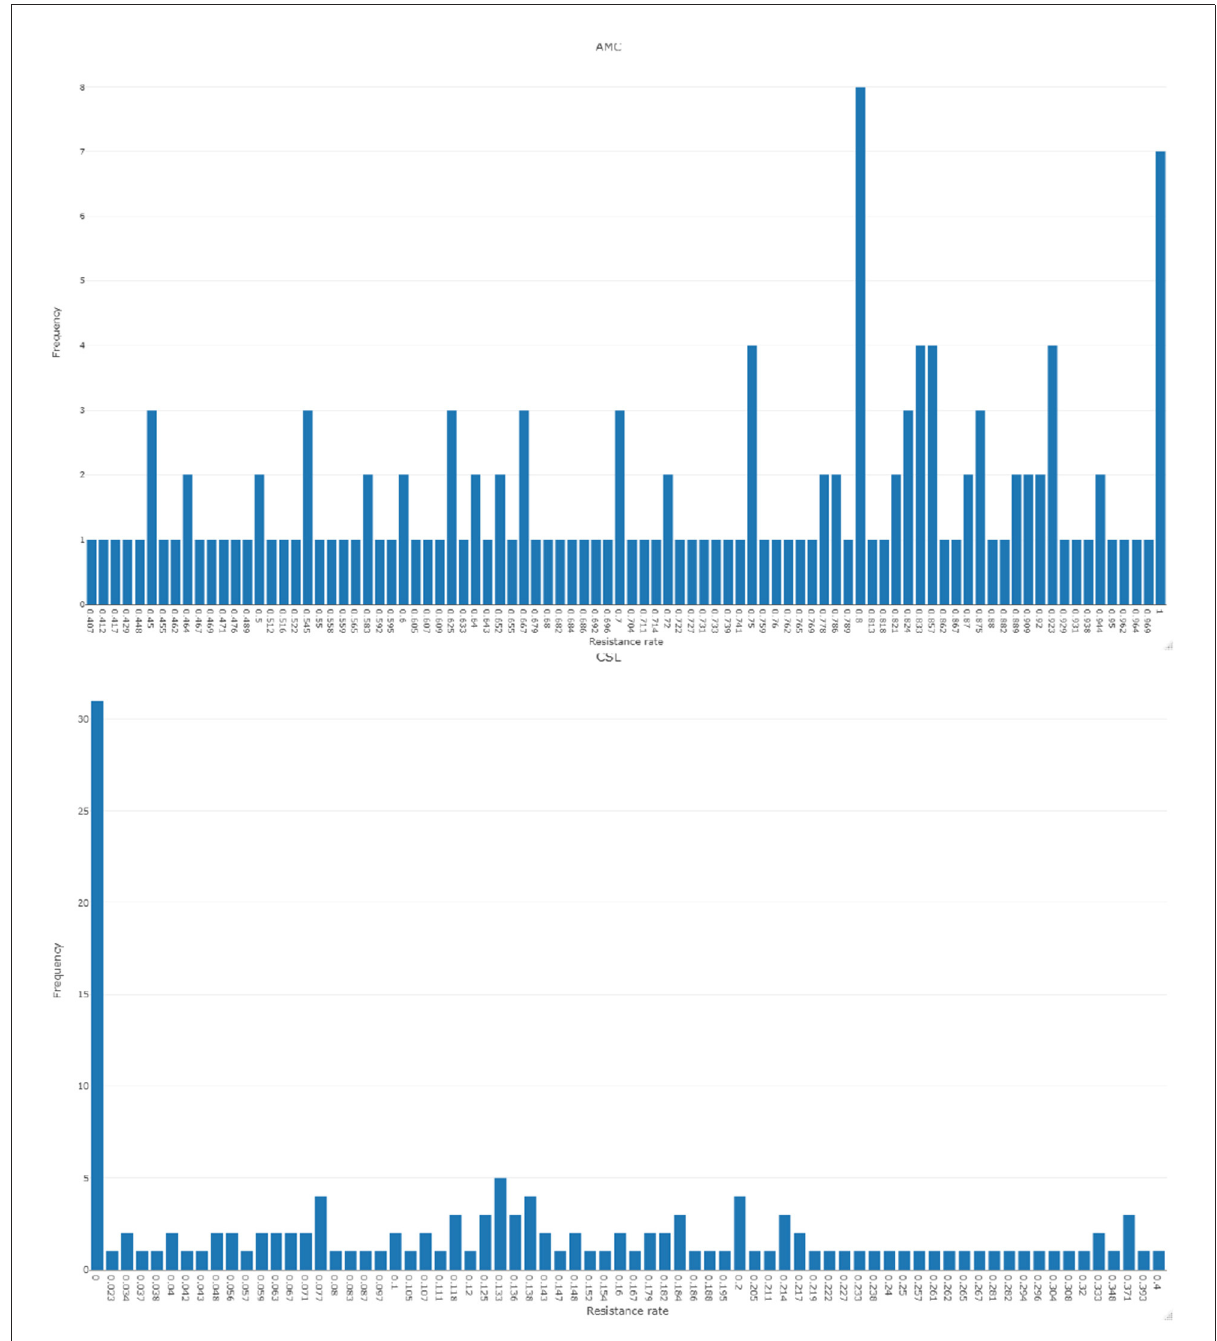
FIGURE2 Histogram of proportion of E. coli in blood resistant to antibiotics AMC and CSL.